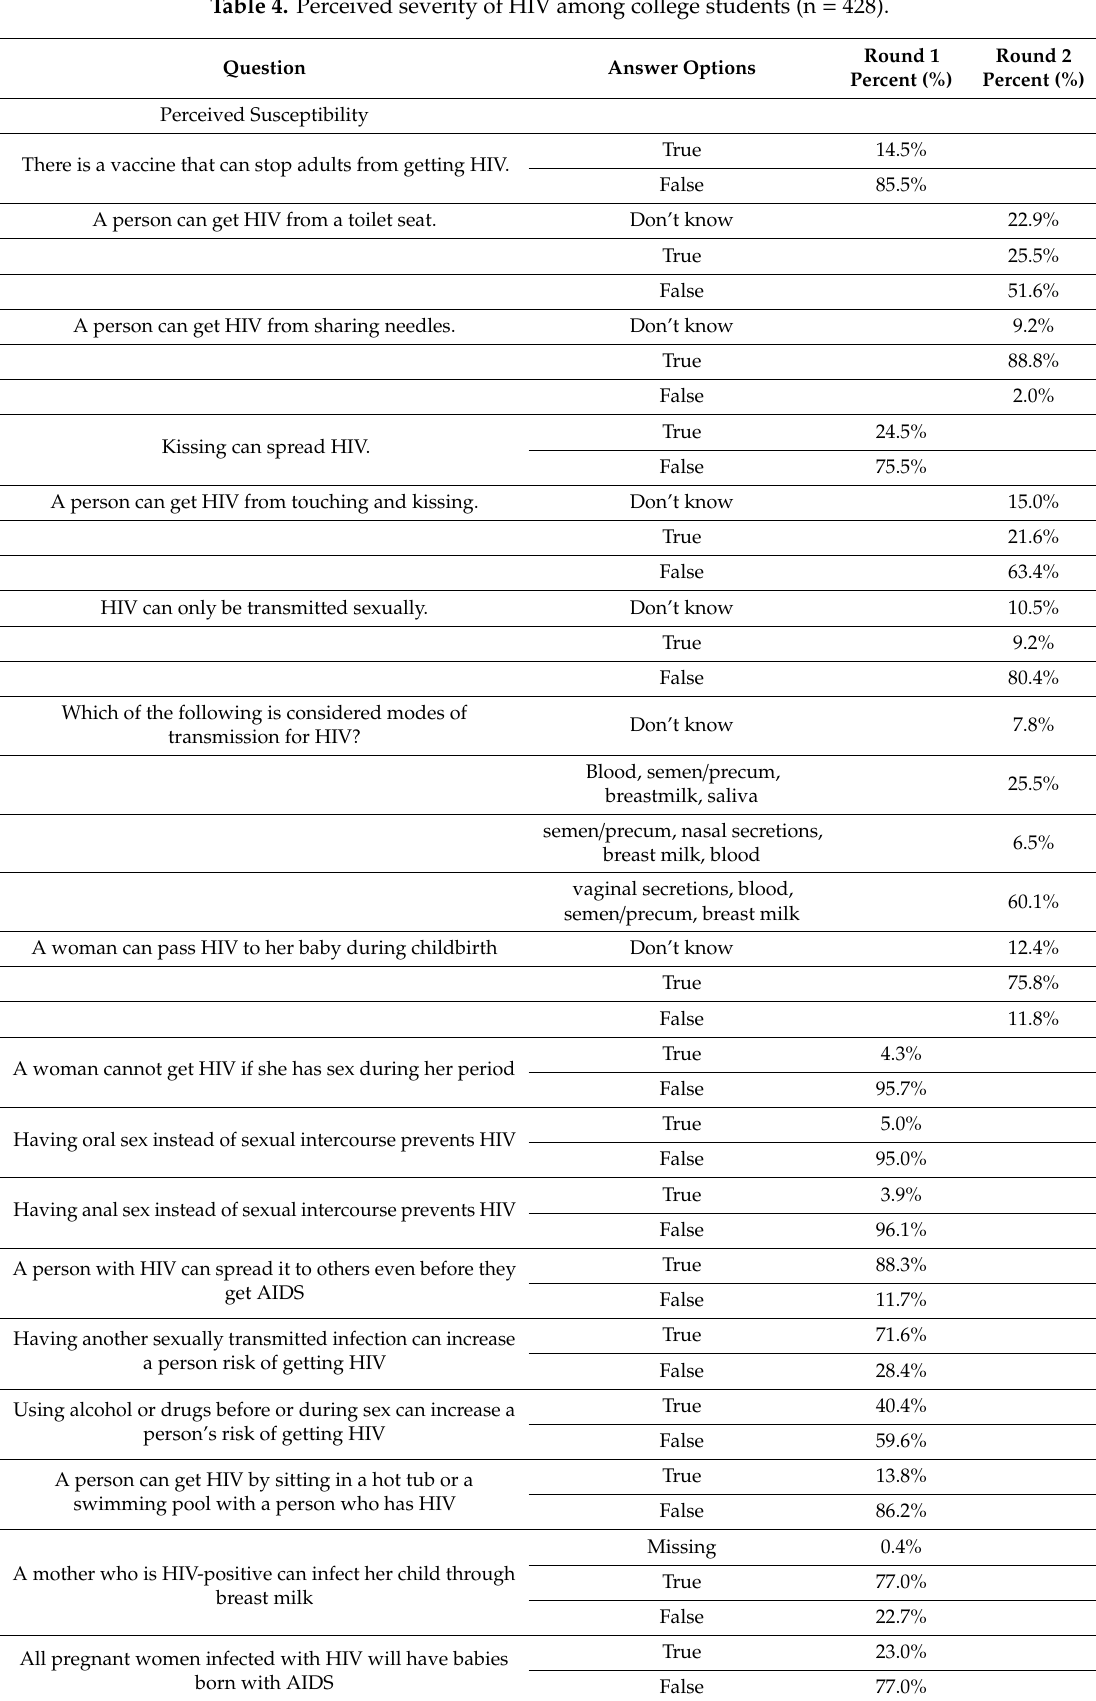
Table 4. Perceived severity of HIV among college students (n =